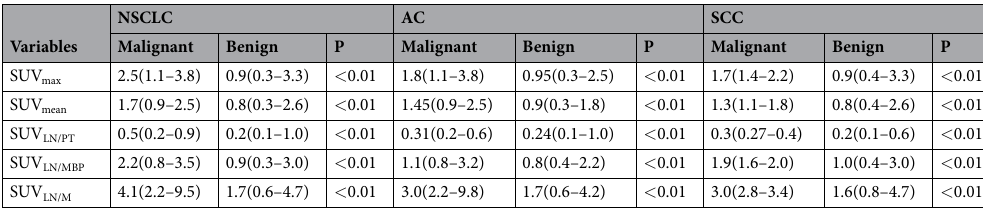
Table 1. Characteristics of lymph node stations at 18 F-Alfatide PET/CT. All data represent median (range).